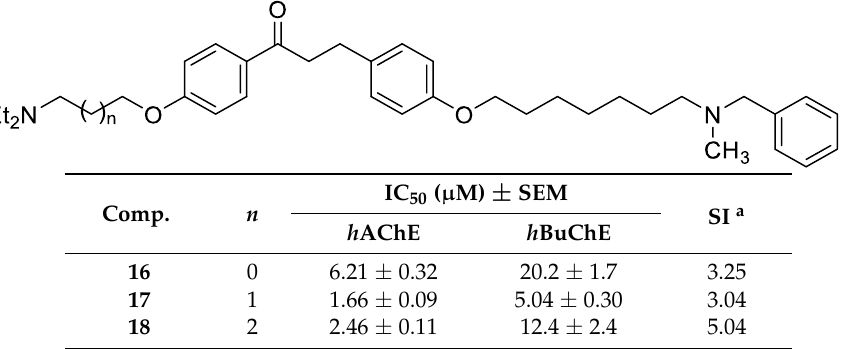
Table 2. Inhibitory activities against h AChE and h BuChE, as IC 50 values, of compounds 16 – 18 .